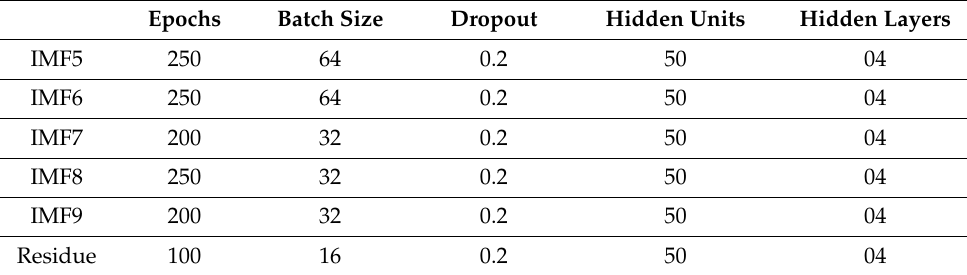
Table 10. Hyper-parameters of the Akima-EMD-LSTM model. Epochs Batch Size Dropout Hidden